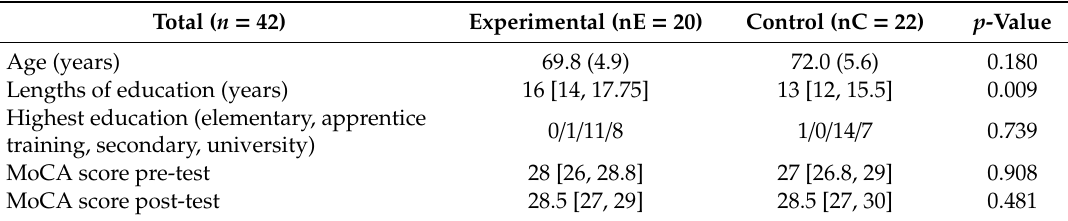
Table 1. Demographic and Montreal Cognitive Assessment (MoCA) characteristics of the experimental and control